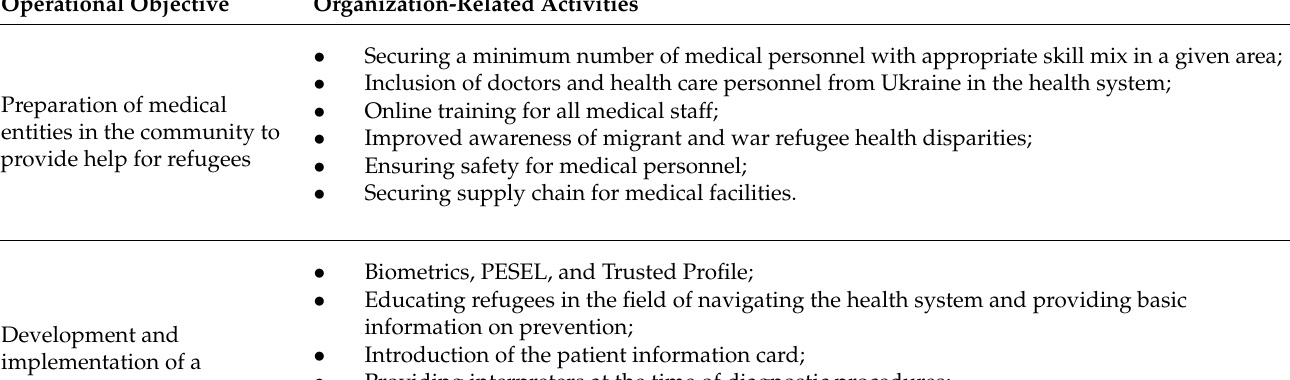
Table 2. Operational objectives accompanied by organization-related